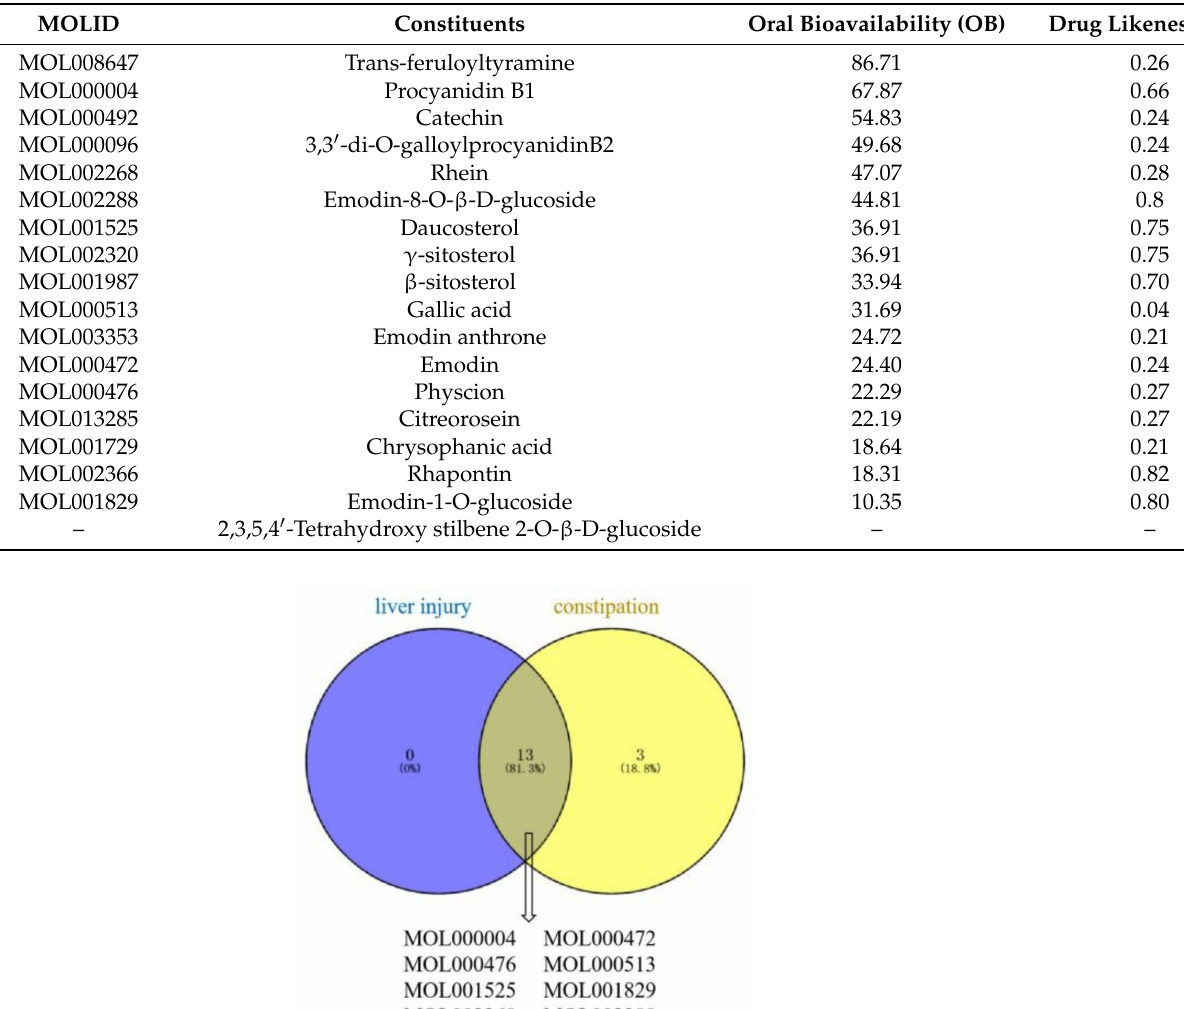
Table 4. PM active constituents.